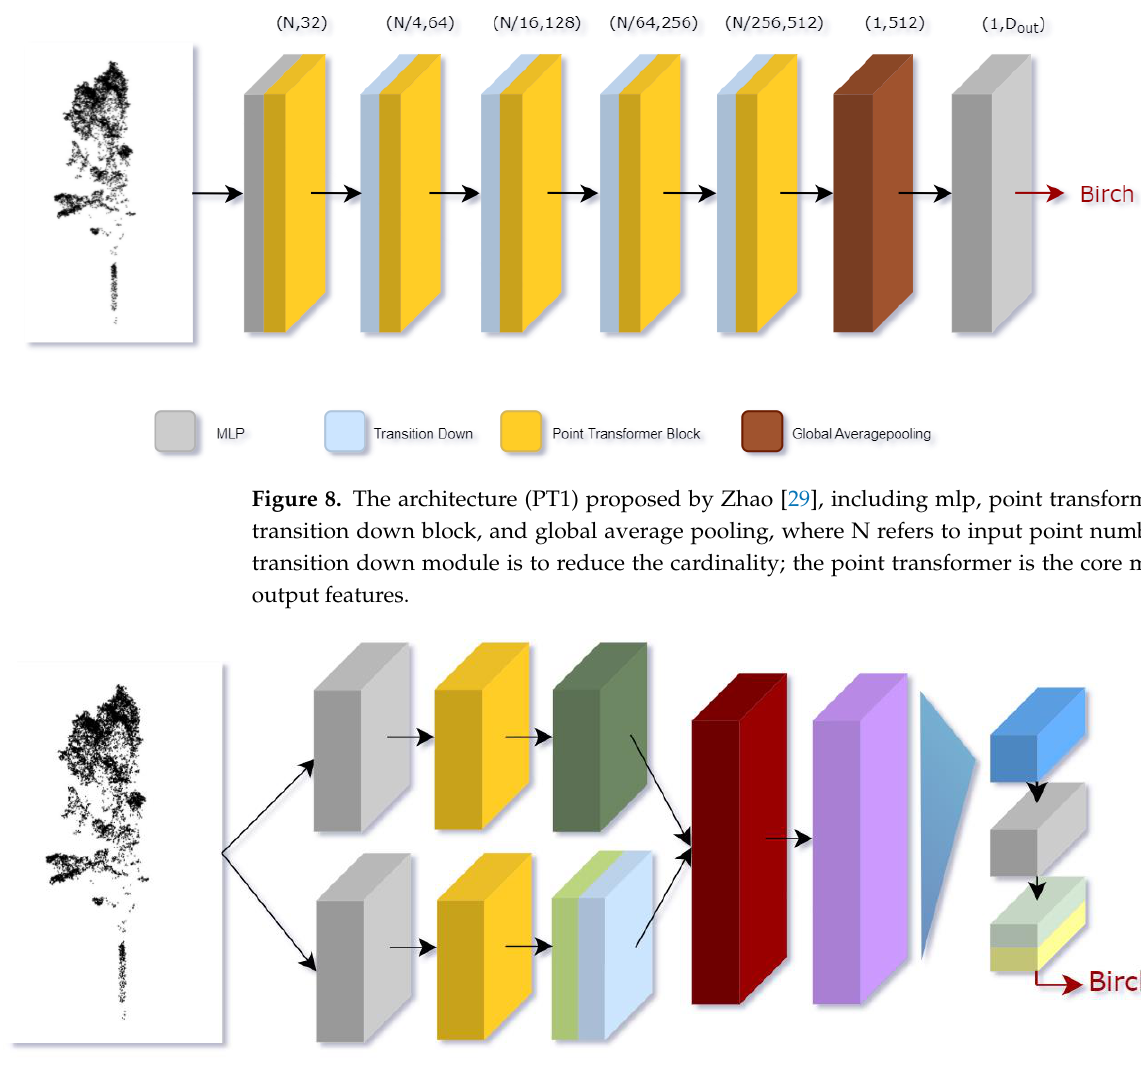
Figure 10. The classification section of structure of PointNet++. The core module of PointNet++ is the SA (set abstraction) module, which mainly in- cludes the following three steps: random sampling, grouping, and feature extraction us- ing PointNet. The SA module first uses the farthest point sampling to randomly sample points in the original point cloud and uses the sampled point as the center point to select points in the sphere within the specified radius. These points are taken as a group, features